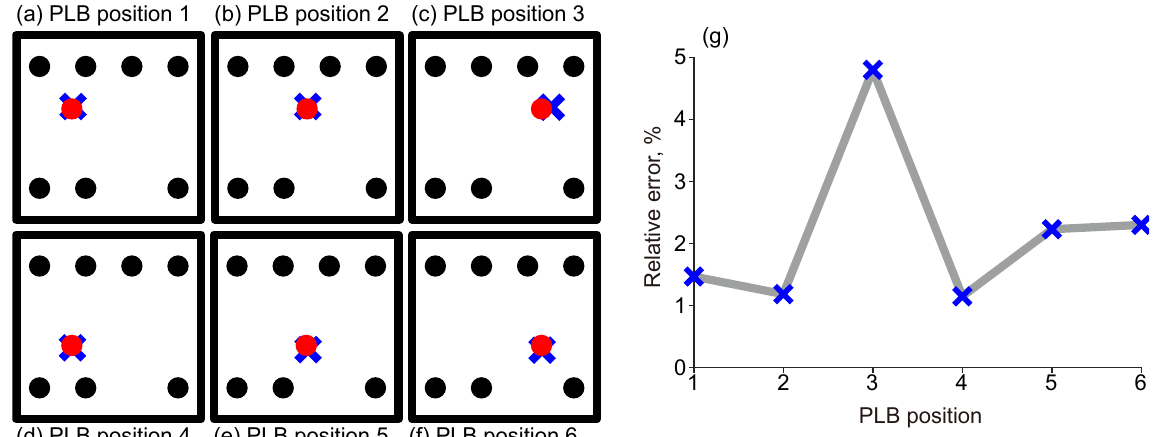
Figure 8. Result figures of PLB testing on CFRP with six different PLB positions, which are shown as red marks in ( a – f ). The estimated locations from ( a ) to ( f ) are indicated by blue plus signs (+), and the positions of the sensors are indicated by black dots. Relative errors for all six different PLB positions are shown in ( g